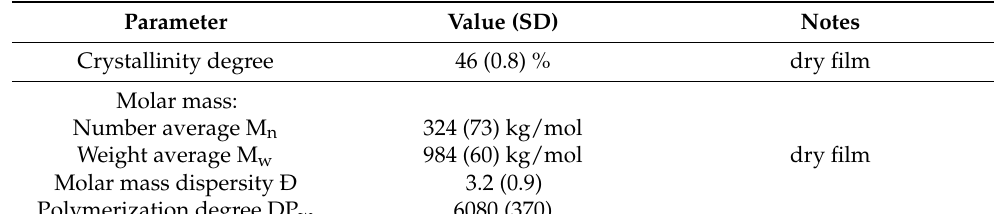
Table 1. Properties of the raw bacterial cellulose film.